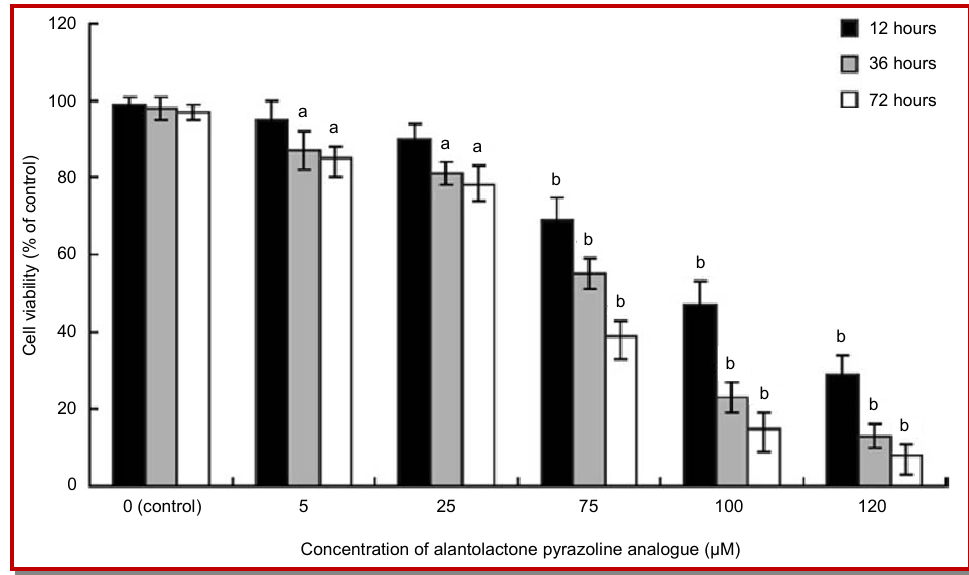
Figure 1: Effect of alantolactone pyrazoline analogue (APA) on cytotoxicity of NSCLC cells. The cells were treated with APA at the indicated concentration for 12, 36, and 72 hours. Cell viability was assessed by MTT assay. The data are expressed as per- centage of control and each value represents mean ± SD of three independent experiments. a p<0.05, b p<0.01 versus